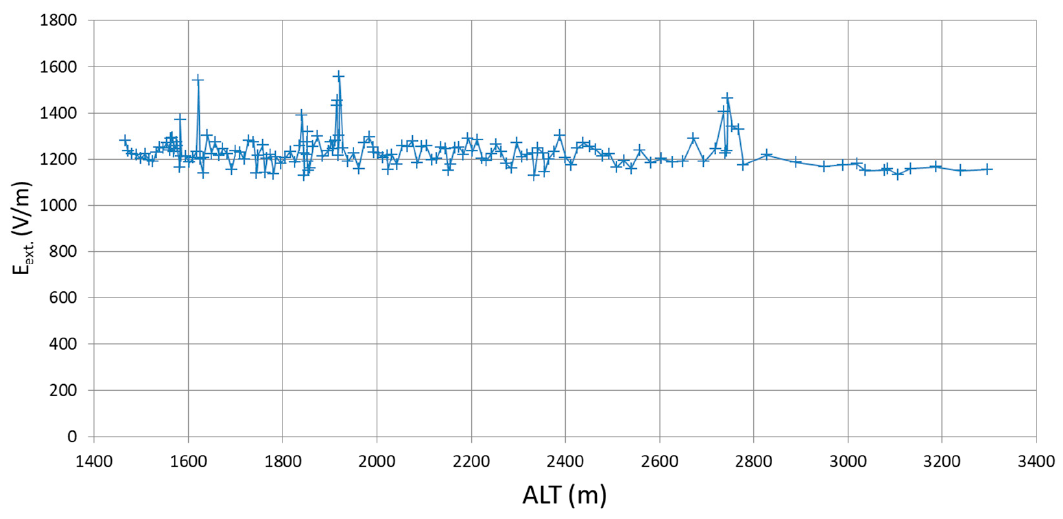
Figure 12. The calculated (by Equation (3)) external electric field strength E ext . for the altitudes between 1500 and 3400 m.